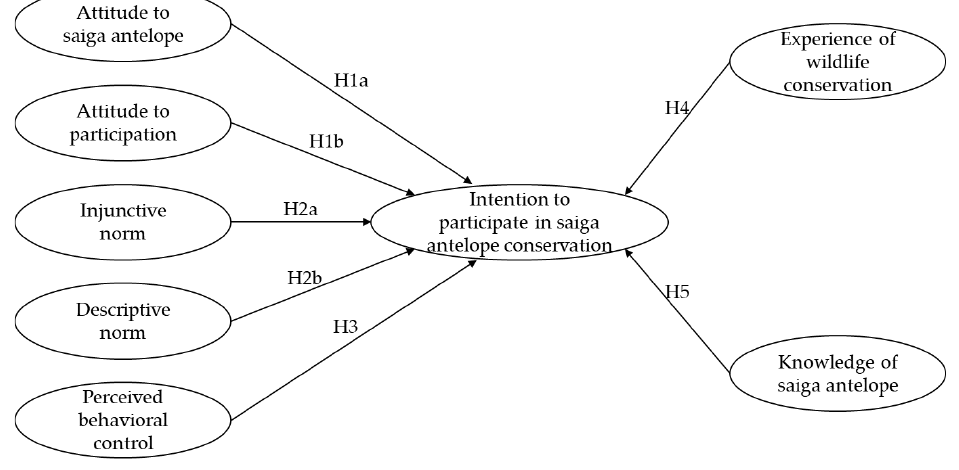
Figure 1. Theoretical framework and